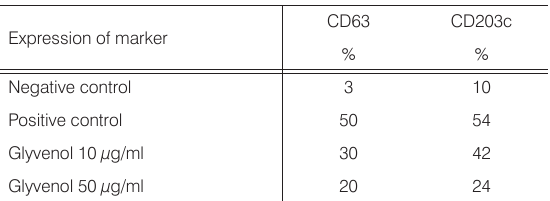
Table 2. Positive result of BAT in patient No.